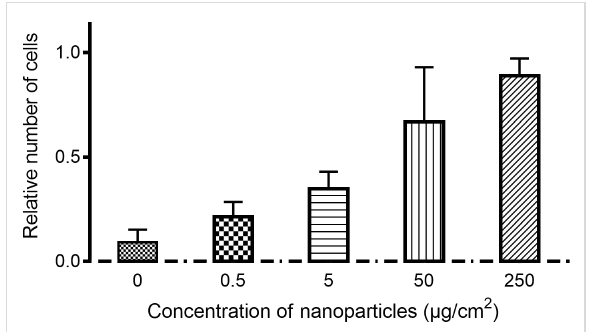
Figure 5: Relative number of adherent endothelial cells after 3 days of incubation with silicone-coated glass coverslips functionalized with GaN nanoparticles compared to uncoated, untreated coverslips. Values are expressed as mean ± standard deviation of 3 independent experiments with 2